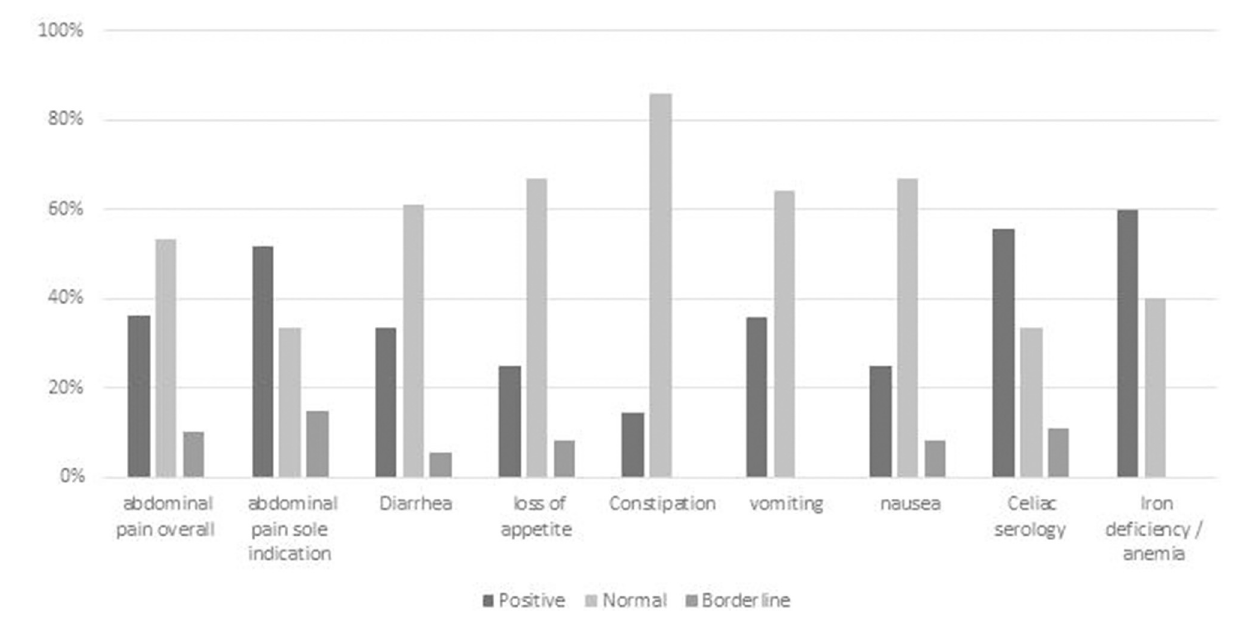
FIGURE 3 | Diagnostic yield of GIE in subgroup analysis of abdominal pain with different joint referral indications. Positive = definite diagnostic finding relating to indication; Borderline = finding of uncertain relationship to indication or minor finding of uncertain significance; Negative = no finding or incidental finding unrelated to indication. AP, abdominal pain; celiac serology < x3